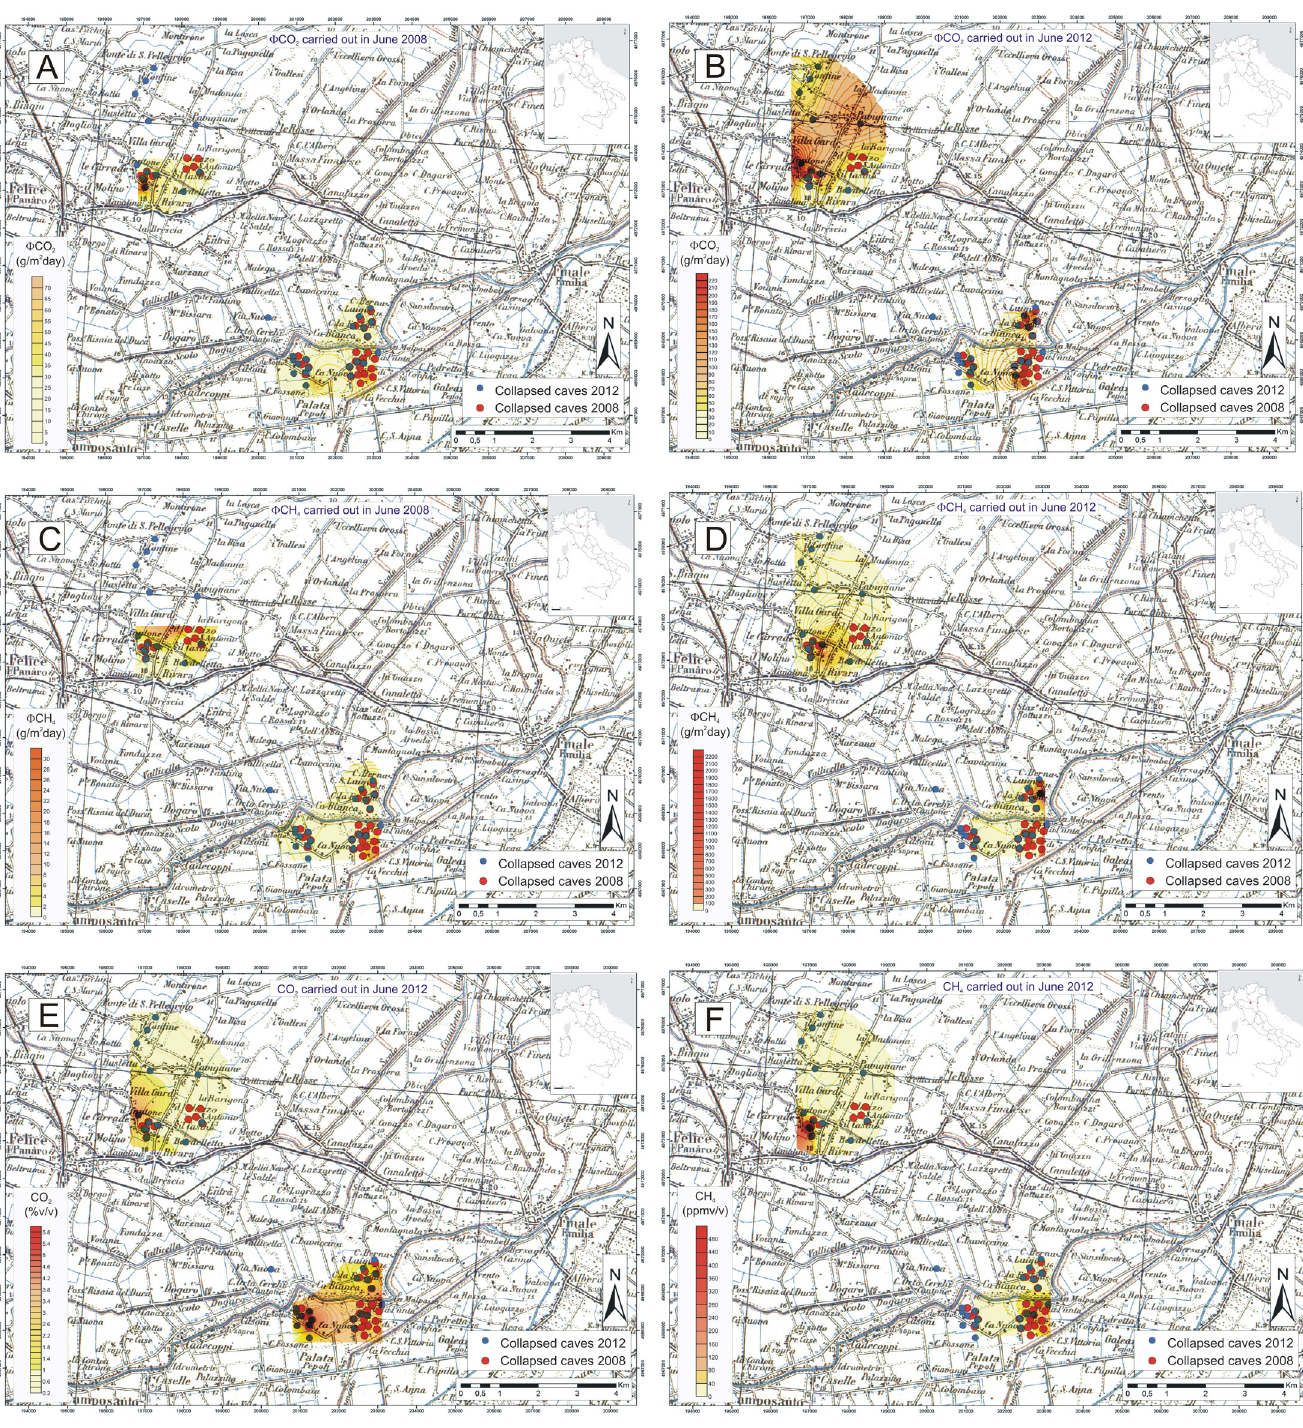
Figure 4. Collapsed cave contour maps in the Finale Emilia, Camposanto and Ponte San Pellegrino areas (Modena). A, B. z CO 2012, respectively. C, D. z CH measured in 2008 and 2012, respectively. E. CO 4 2012. Green dots, 2008 sampling points; red dots, 2012 sampling points. The areal distribution has different extents due to different numbers of sampling points in 2008 and